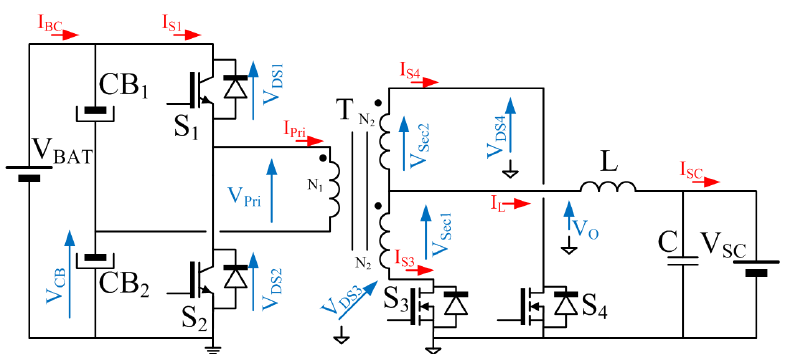
Figure 2. Layout of Half-Bridge Current-Source (HBCS) bidirectional converter. The references for the current and voltage considered for the analysis are